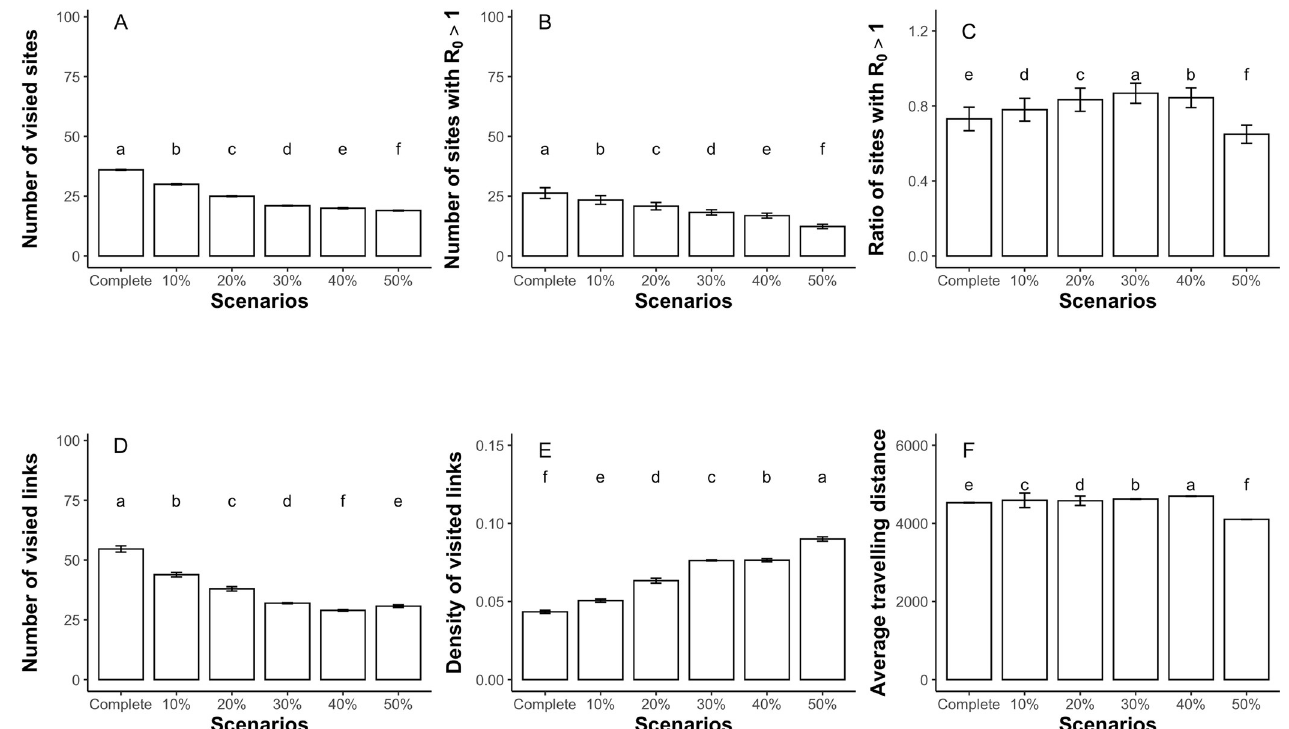
Fig 2. The basic metrics (mean ± SD) of the visited networks under increasing site removal. On the x axis, from left to right, the scenario of the complete network, and the network scenarios of 10%, 20%, 30%, 40% and 50% site removal. The lowercase annotations indicate the statistic difference according to Kruskal-Wallis tests (p <